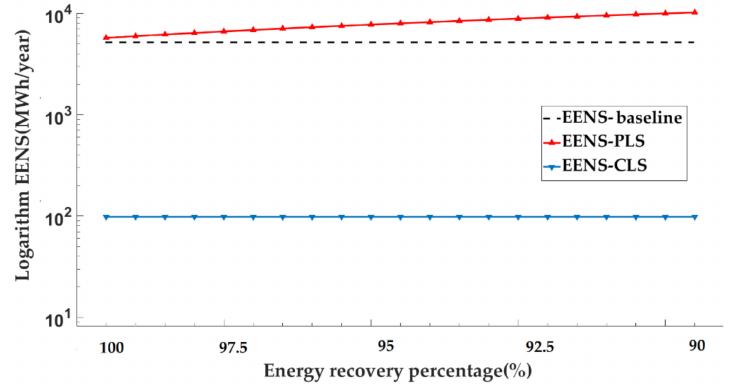
Figure 12. EENS of PLS and CLS for Model